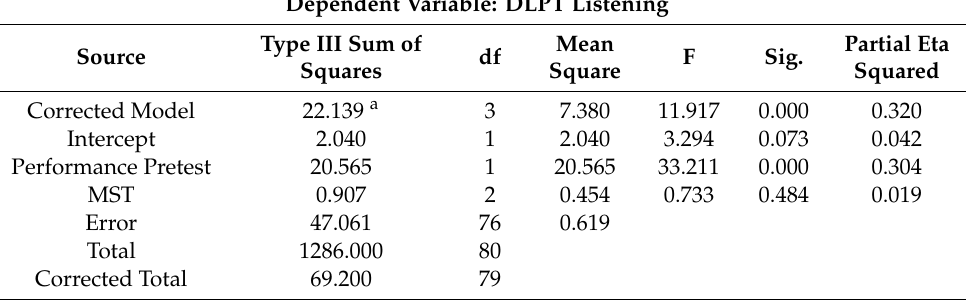
Table 8. Tests of between-subjects e ff ects on Defense Language Proficiency Test (DLPT) listening